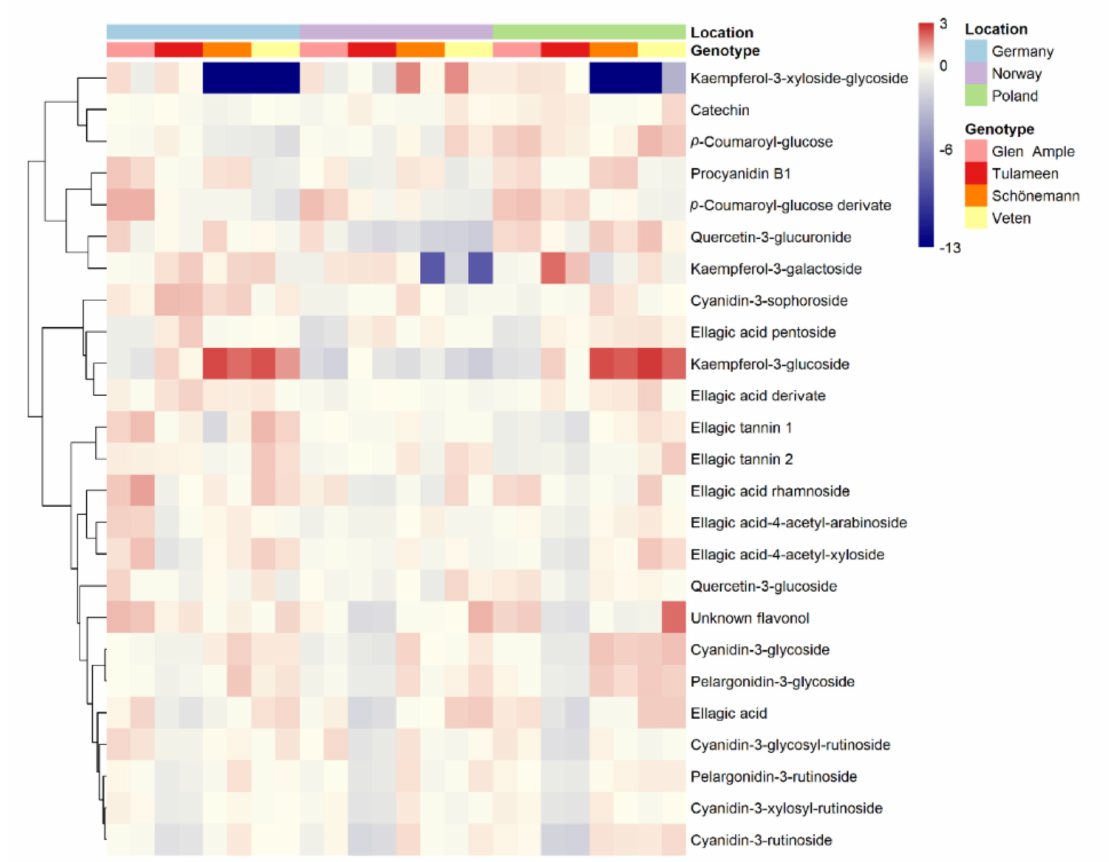
Figure 3. Heatmap visualization of raspberry secondary metabolites identified in 2018 in two different harvests. Each value represents the normalized (median-centered and log 10 -transformed) mean of three biological replicates, with red and blue colors denoting relatively high and low intensities. Metabolites are clustered based upon Pearson correlation coefficients. Samples’ location and genotype are indicated with color